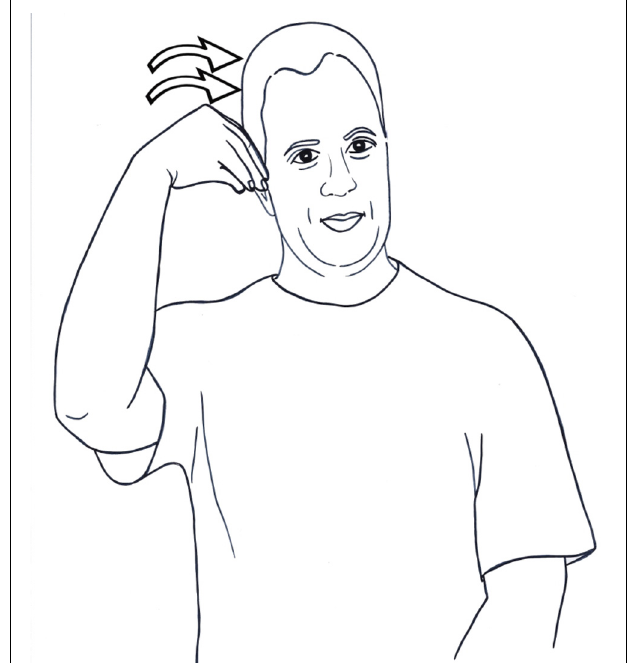
FIGURE 2 | An iconic sign used metaphorically to represent an abstract action: LEARN